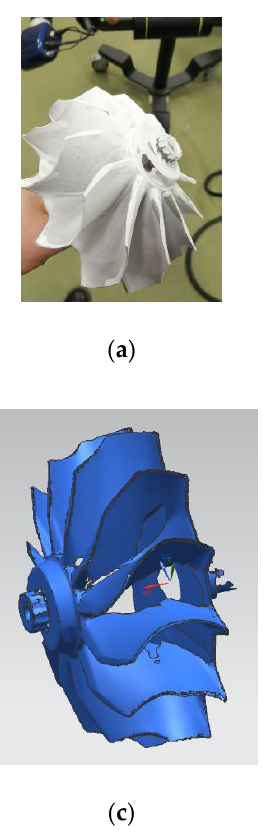
Figure 2. ( a ) The turbine rotor that was used for computational domain, ( b ) scanning process of the turbine wheel ( c ) the scanned geometry, ( d ) the generated 3-D model of the turbine wheel.